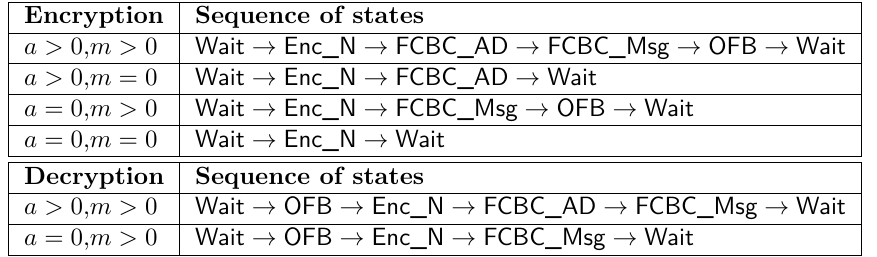
Table 14: Execution order of states for encryption/decryption and depending on the above points